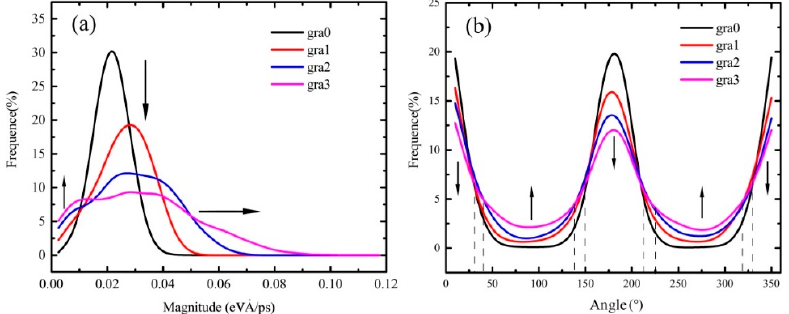
Figure 7. Magnitude and angle distribution of atoms heat flux vectors in fractal graphene statistically. ( a ) Magnitude distribution; ( b ) angle distribution.